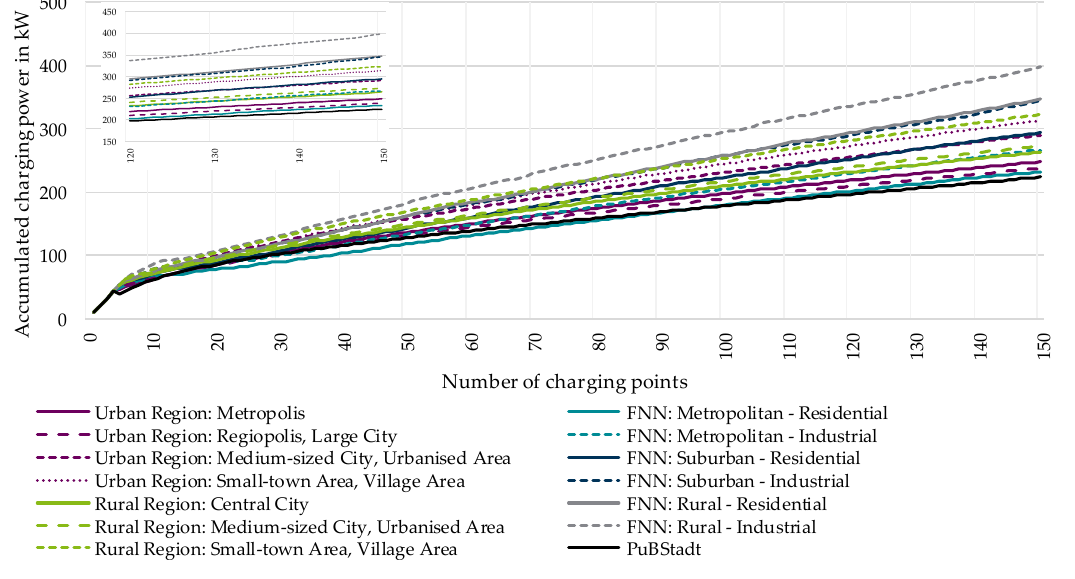
Figure 27. Accumulated charging power (ordinate) for 11 kW charging power with seven different area types, six area types according to FNN and the results from PuBStadt for 150 charging points.